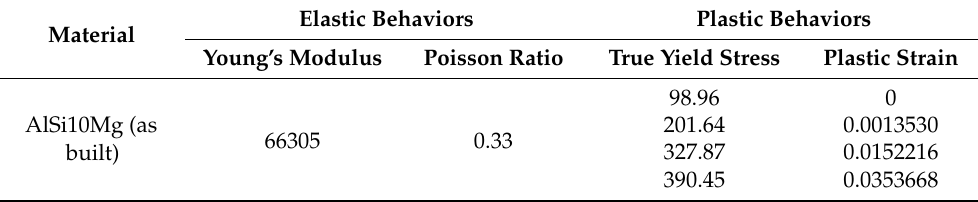
Table 3. Material property data of AlSi10Mg applied to the finite element